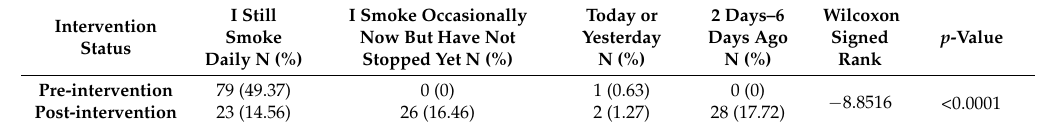
Table 6. Smoking reduction (N = 79).